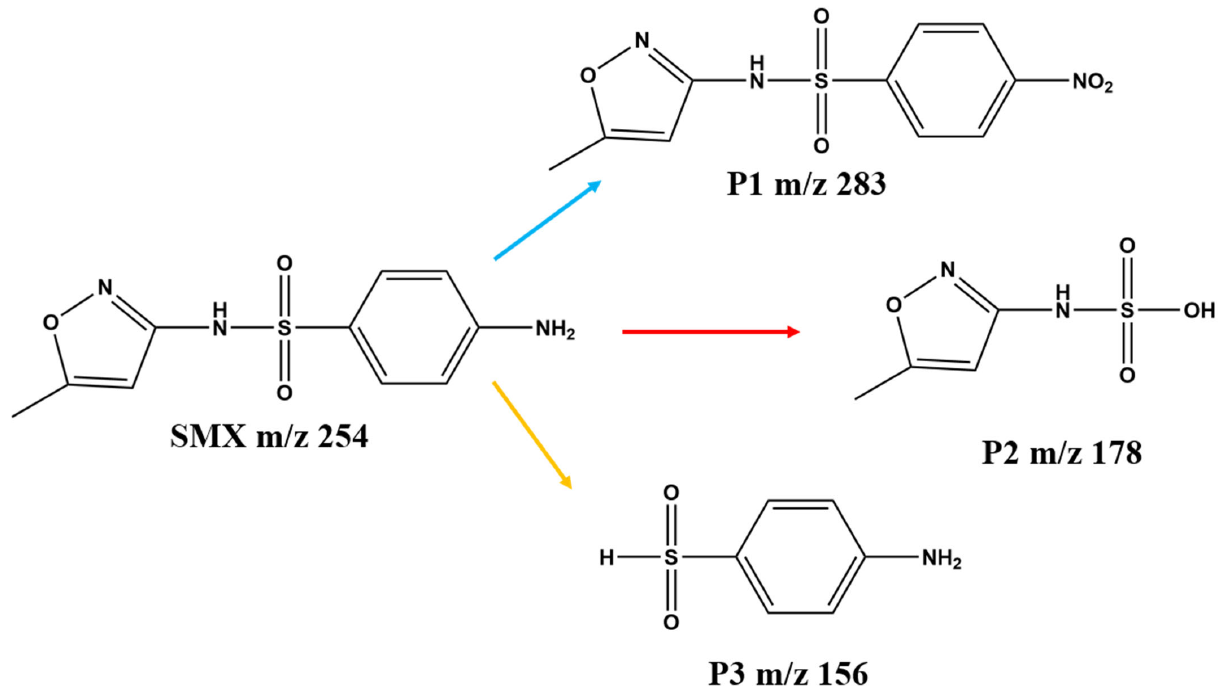
Figure 7. Possible pathways of SMX degradation.